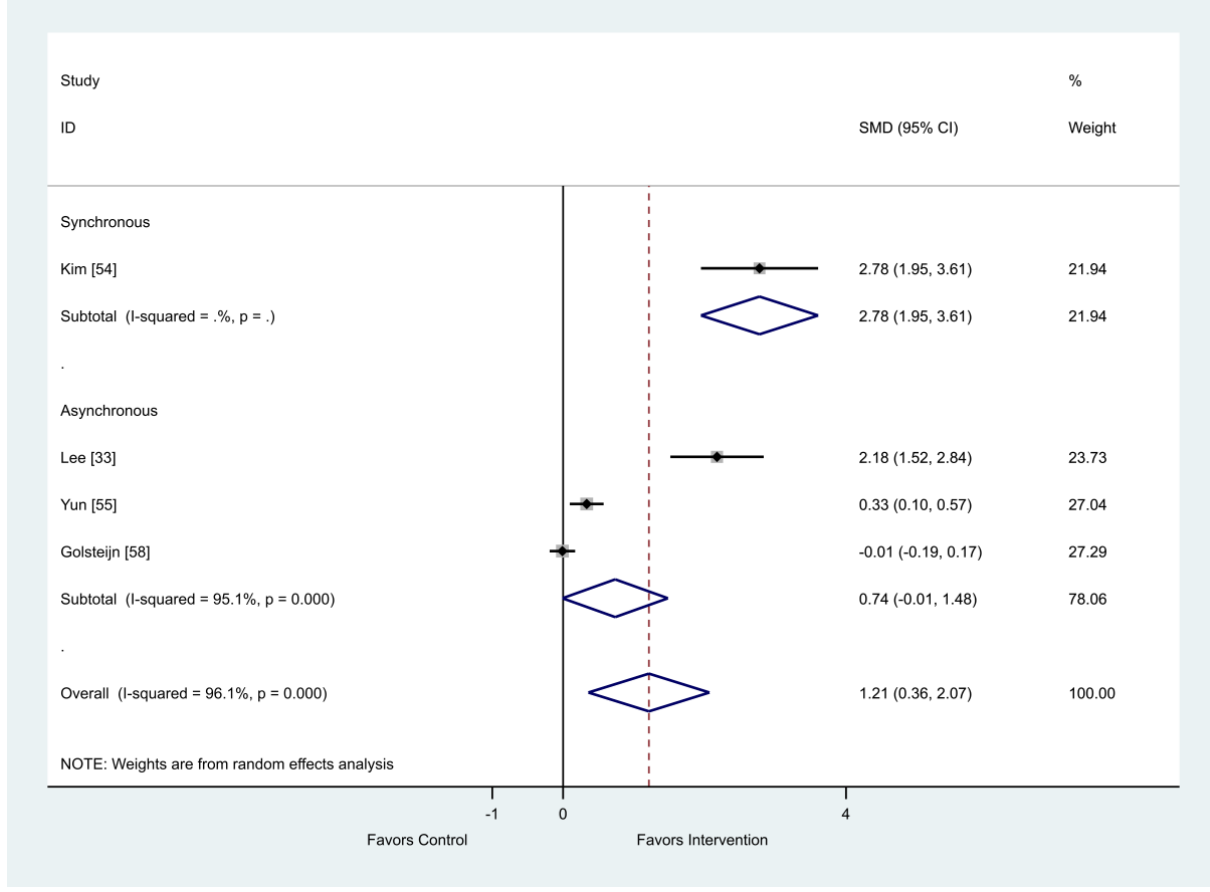
Figure 11. Effect of electronic health interventions versus control group on anxiety interventions, analyzed using standardized mean difference (postintervention mean and SD). Lower scores indicate improved anxiety. SMD: standardized mean